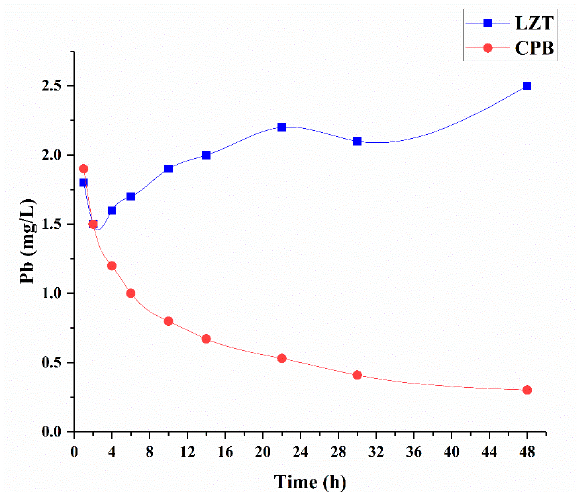
Figure 5. Lead (Pb) concentration in static leachate of lead–zinc tailing (LZT) and backfill samples.